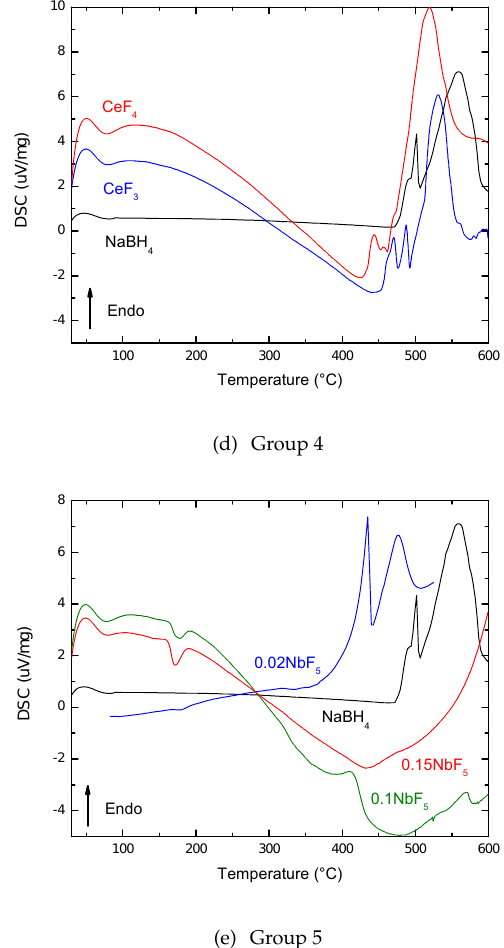
Figure 4. DSC-Netzsch corresponding to the samples distributed in the same different groups as in Figure 3. The numbers on the right-hand side indicate the shift applied to the data for